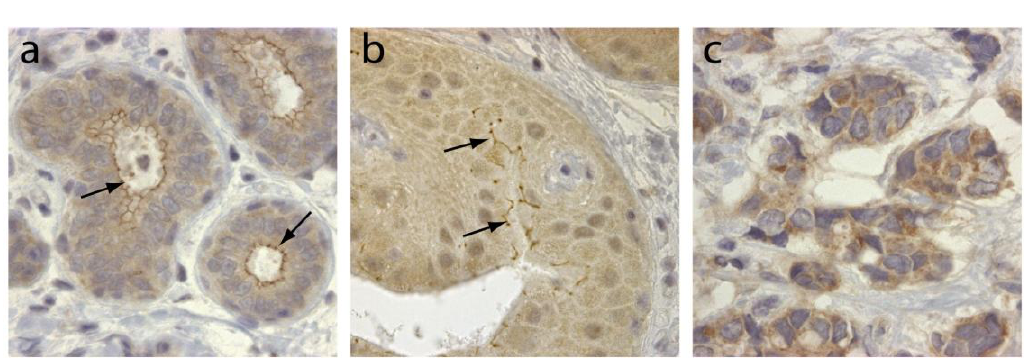
Figure 2. TRAF4 expression in normal breast and cancerous tissues. Immunohistochemistry of TRAF4 expression (brown) in normal breast ( a ), in situ carcinoma ( b ) and invasive carcinoma ( c ). Note that TRAF4 localization is modified from a predominantly membrane-associated presence in normal breast (a, arrows) to a mainly cytoplasmic presence in invasive tumor cells (c); in situ carcinomas represent an intermediate state in which TRAF4 remains associated focally with the membrane (b,